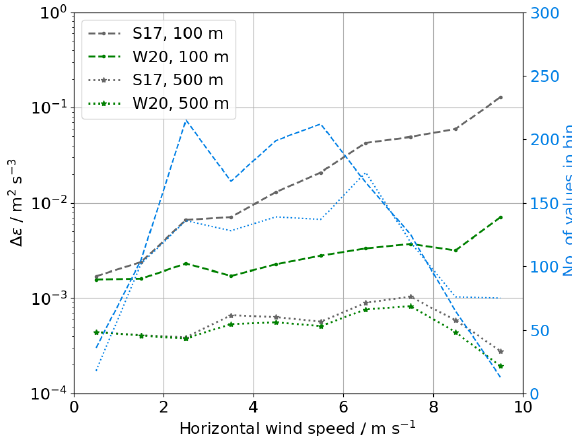
Figure 10. Difference of lidar ε retrievals for both kinds of VAD as a function of wind speed.